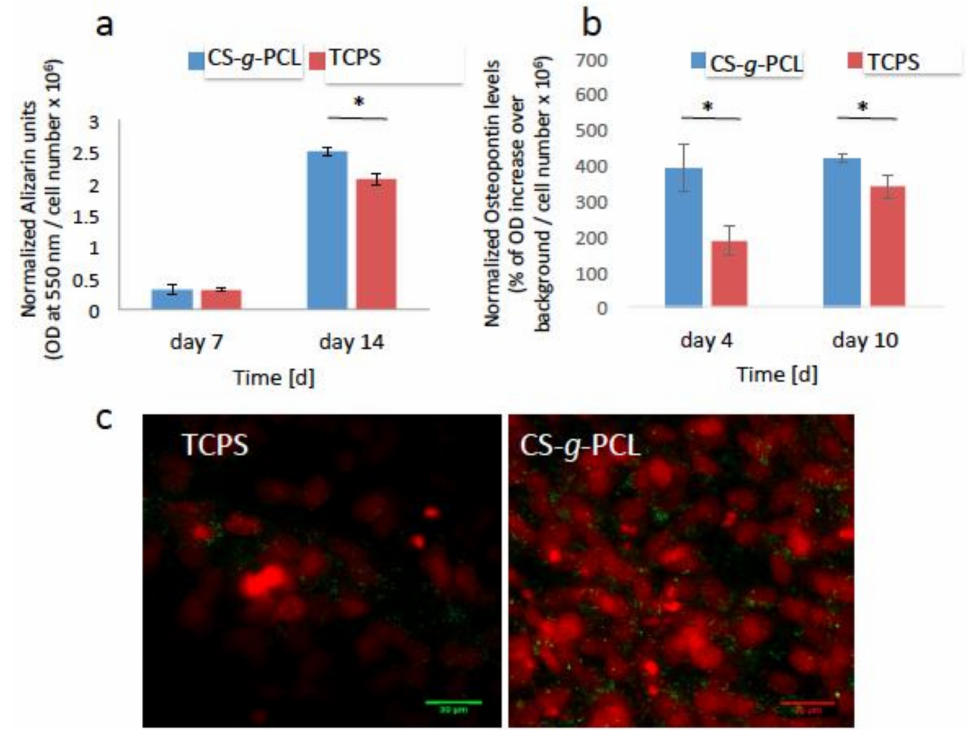
Figure 7. Late markers of osteogenesis normalized by the cell number: ( a ) Calcium biomineralization by Alizarin Red S staining of the MC3T3-E1 cells cultured for 7 and 14 days on CS- g -PCL and TCPS. The matrix mineralization of the copolymer substrate was significantly increased compared to TCPS after 14 days of culture; ( b ) Measurement of the endogenous levels of osteopontin of the pre-osteoblastic cells cultured on the two material surfaces for 4 and 10 days. Osteopontin levels were significantly higher on the CS- g -PCL surfaces compared to TCPS after 4 and 10 days in culture; ( c ) Confocal microscopy images demonstrate the endogenous expression of osteopontin on the two material surfaces 10 days after seeding. Osteopontin is depicted in green around the red cell nuclei. The expression is higher for cells cultured on the CS- g -PCL surface compared to TCPS 10 days after seeding. Original magnifications are 40 × and scale bars represent 30 µ m. Error bars represent the average of triplicates ± SEM of two independent experiments ( n =